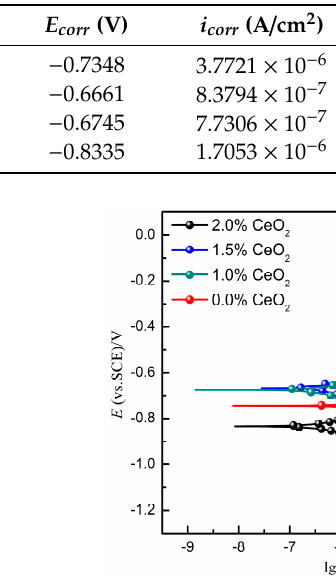
Table 4. Electrochemical data of coatings with different contents of CeO 2 .